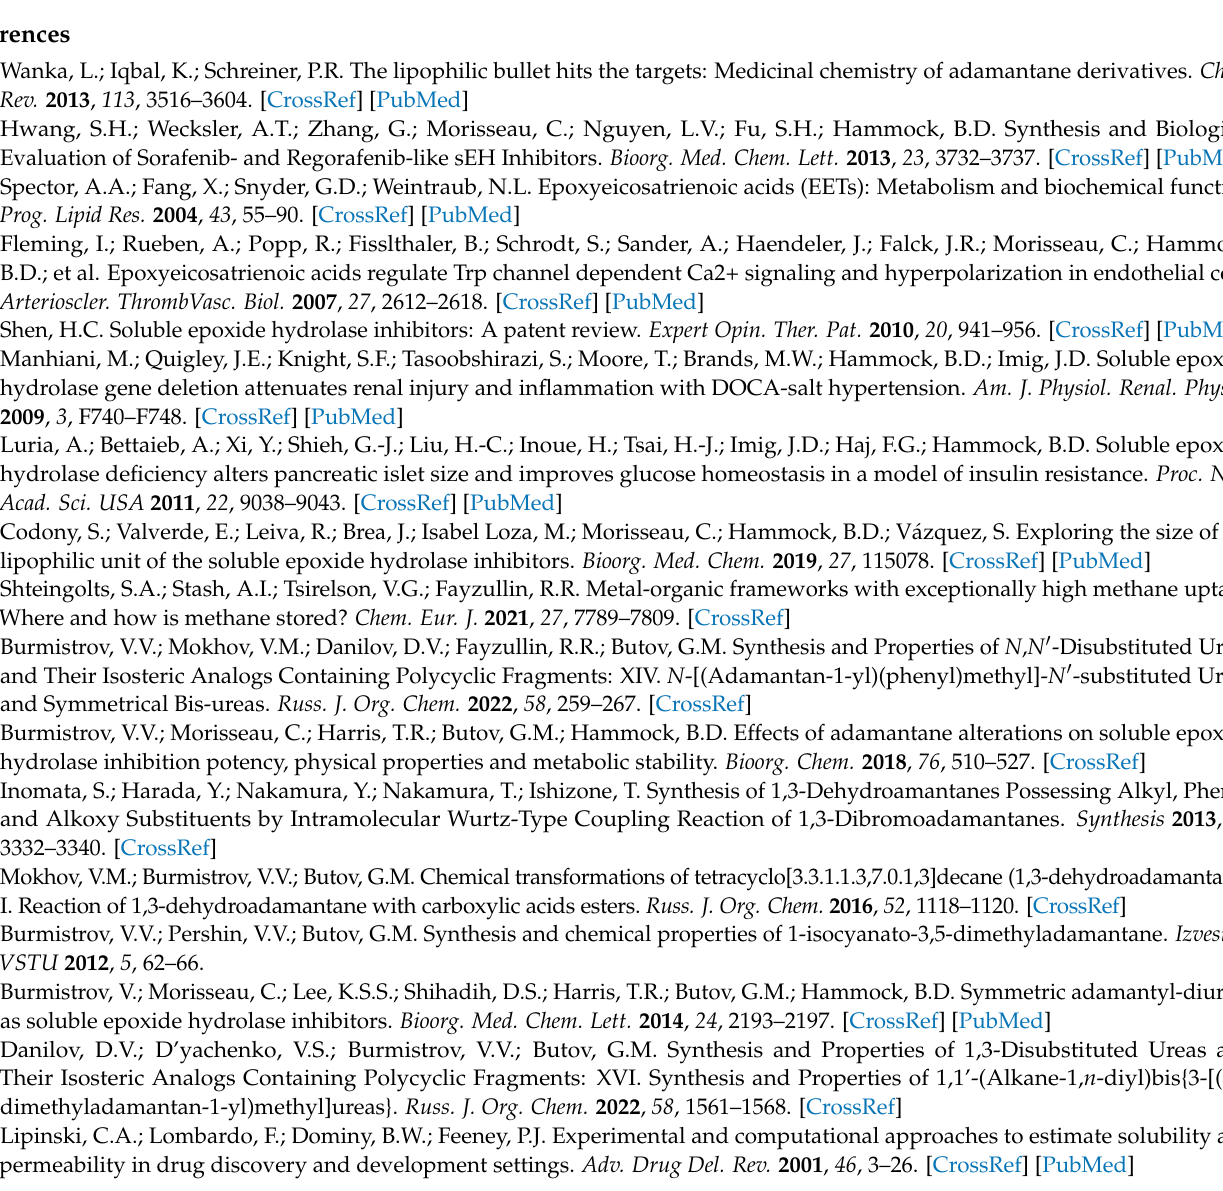
NMR of compound 10a . Figure S35. 13 C NMR of compound 10a . Figure S36. 19 F NMR of compound 10a . Figure S37. 1 H NMR of compound 10b . Figure S38. 13 C NMR of compound 10b . Figure S39. 1 H NMR of compound 10c . Figure S40. 13 C NMR of compound 10c